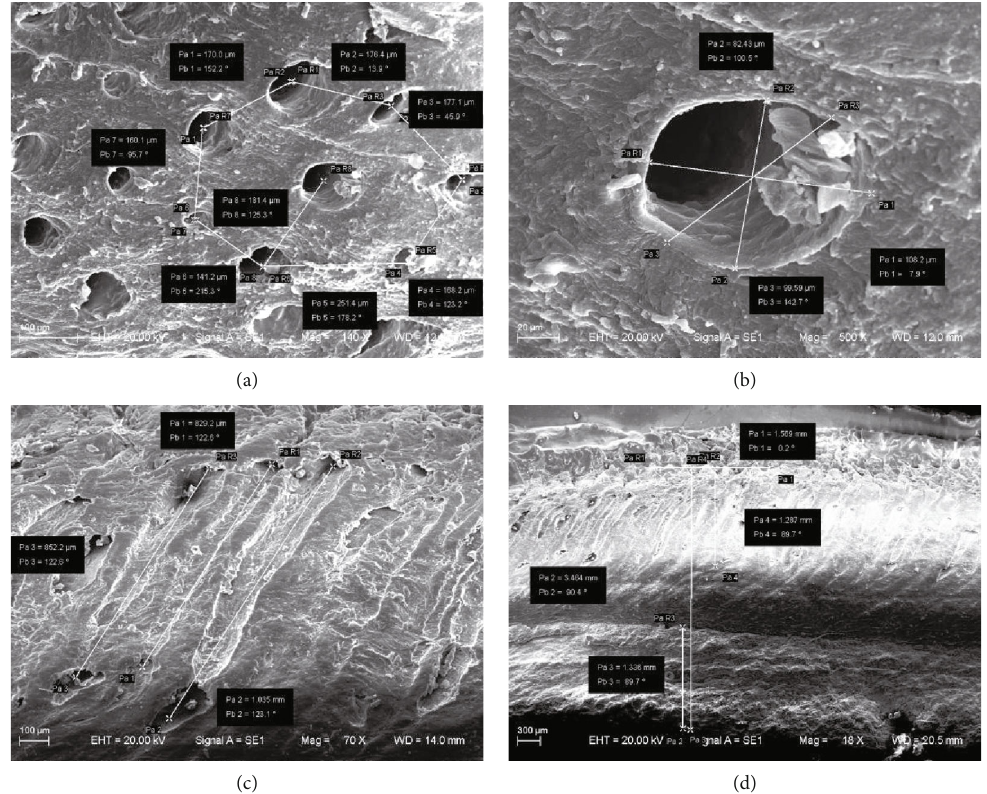
Figure 3: The measurement of the tubes by SEM: (a) the tube spacing (b) the diameter (c) the inclined angle, and (d) the thickness.